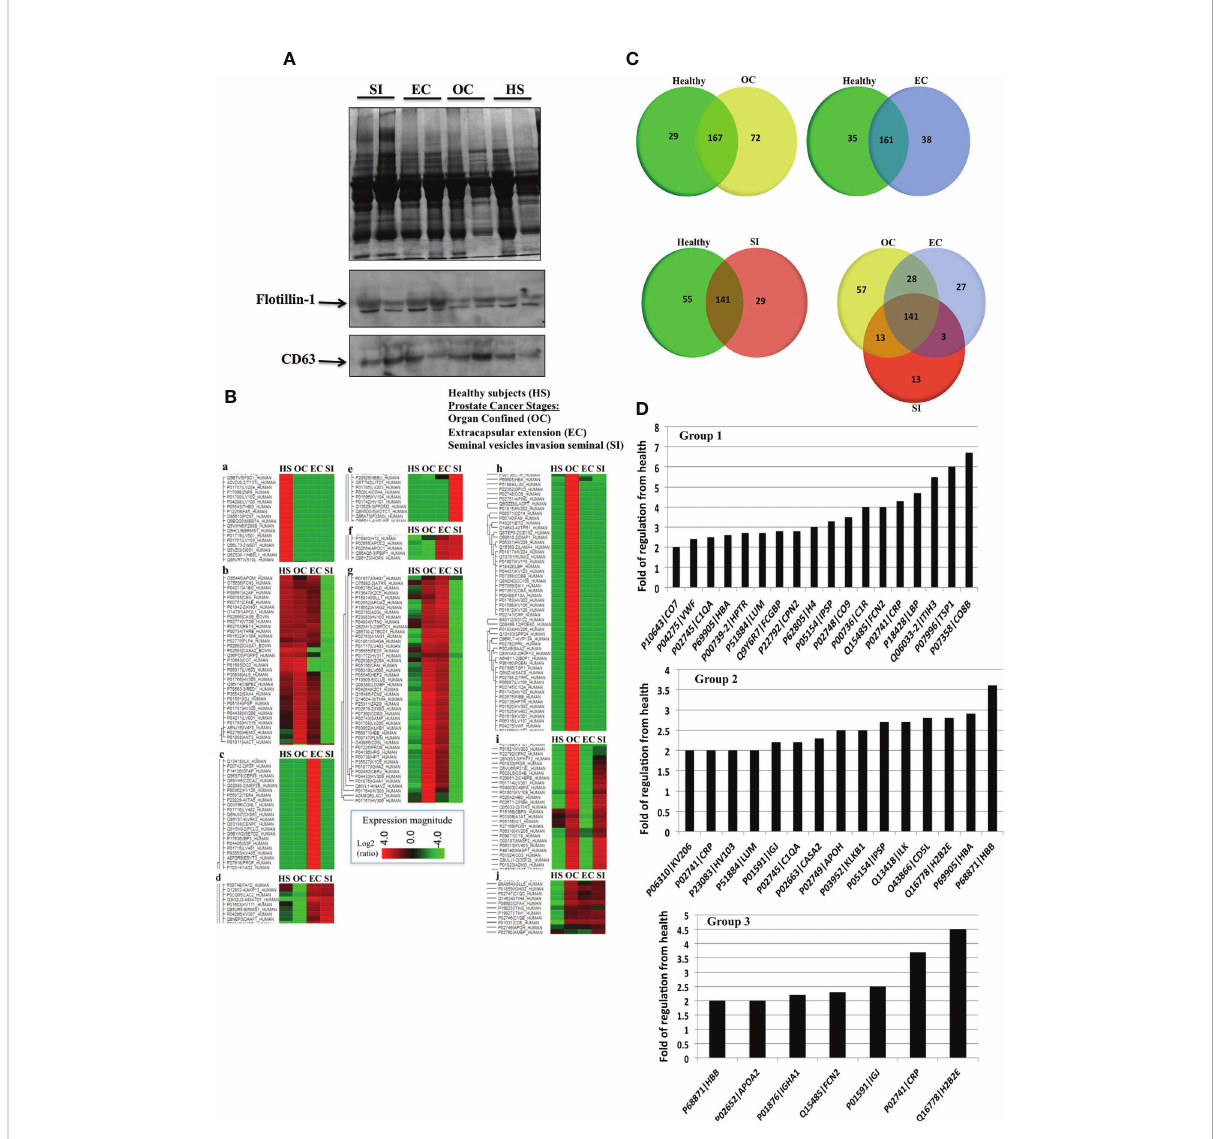
FIGURE 2 (A) A representative Coomassie blue stain SDS-PAGE gel for EVs collected from the plasma of prostate cancer (PC) patients in three stages of the disease and healthy subjects. (B) Proteomic analysis from the blood plasma vesicles of six healthy male plasma samples, six OC patient plasma samples, six extracapsular-extension (EC) patient plasma samples, and six seminal vesicle invasion (SI) patient plasma samples. There were 100 µg of protein from vesicles used for each group. The heat map shows a distinctive protein pro fi le for each stage of the disease compared to healthy subjects. Ten clusters of proteins (a-j) were identi fi ed that could discriminate between PC and healthy subjects, and distinguish the disease stage. Figure shows in principal that EVs proteins could be used as biomarkers for each stage of tumor and relay diagnostic and prognostic information. (C) Venn diagrams illustrating the number of proteins unique to each tumor type group compared to healthy vesicle protein expression (a, b, c), and an expression common and unique to each tumor type (d). (D) Proteins with the highest folds of change from healthy EVs in the EVs of OC patients (Group 1), EC patients (Group 2), and SI patients (Group 3). Each of these values included in the graphs was found to be statistically signi fi cant (p < 0.01) by a Fisher